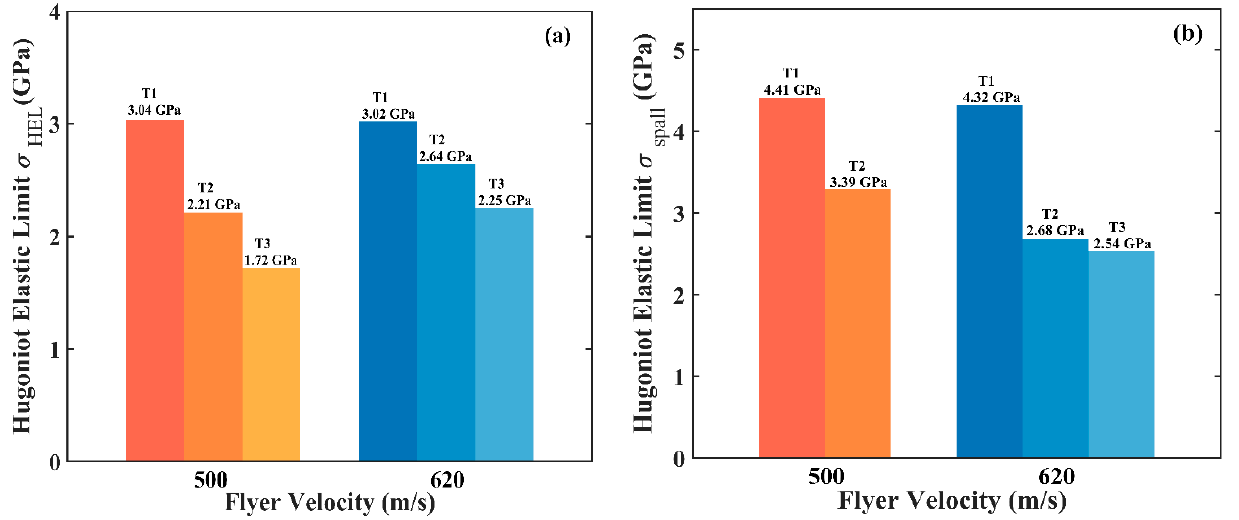
Figure 6. Hugoniot elastic limit ( a ) and spall strength ( b ) of three different TC4 materials produced by SLM. Sample number and loading velocities are indicated on each bar.